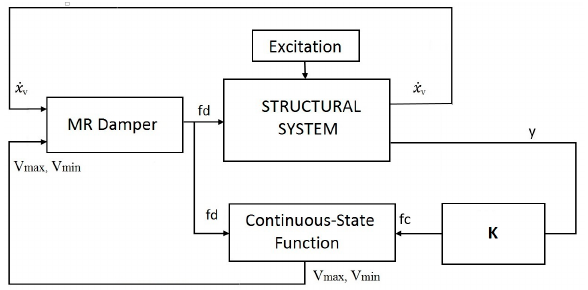
Figure 7. The general semi-active control scheme.